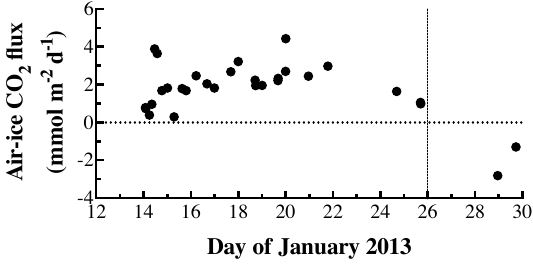
Figure 5. Air–ice CO 2 fluxes (mmolm − 2 d − 1 ). Positive air–ice CO 2 flux means outgassing from the ice, and negative CO 2 flux means uptake of atmospheric CO 2 . The vertical black dotted line on 26 January marks when the heat was turned back